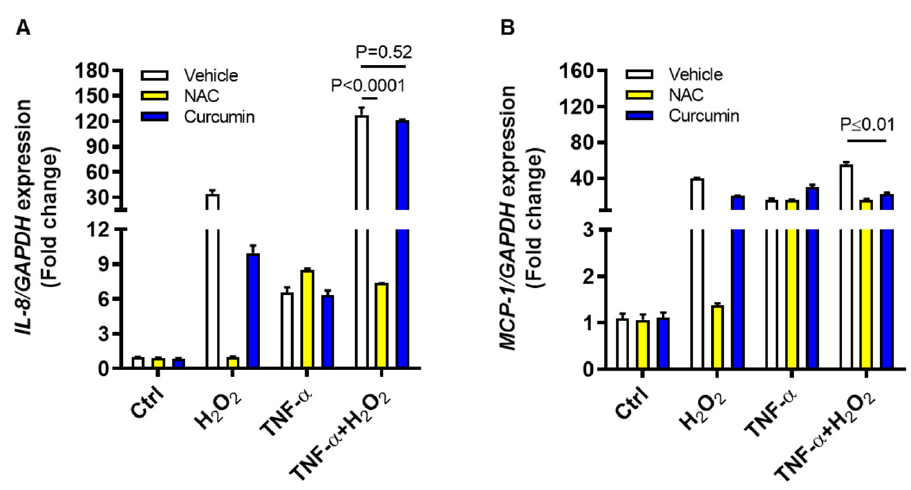
Figure 6. ROS inhibition suppresses the IL8 and MCP1 transcripts expression in monocytic cells co- stimulated with TNF- α and H 2 O 2 . THP-1 cells were stimulated, in triplicate, with TNF- α (10 ng/mL) and/or H 2 O 2 (10 mM) while control cells were treated with vehicle only. In ROS inhibition assays, cells were preincubated for 30 min with either NAC (1 mM) or curcumin (10 µ M) before stimulation with TNF- α and/or H 2 O 2 . Total RNA was extracted and IL8/MCP1 gene expression was assessed by qRT-PCR as described in methods. Two-way ANOVA was used to calculate group differences and p -values less than 0.05 were considered as significant. The representative data (mean ± SEM) obtained from three independent experiments with similar results show effective suppression of ( A ) IL8 mRNA by NAC ( p < 0.0001) and ( B ) MCP1 mRNA by both NAC and curcumin ( p ≤ 0.01).